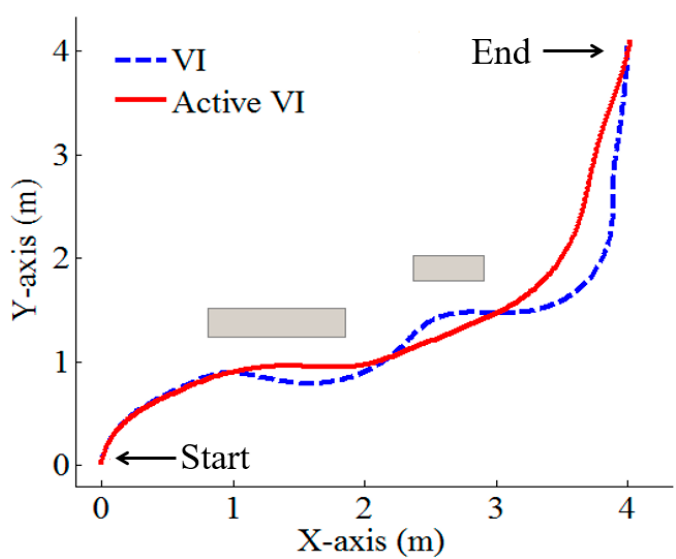
Figure 13. Experimental results of collision-free navigation with multiple fixed obstacles.